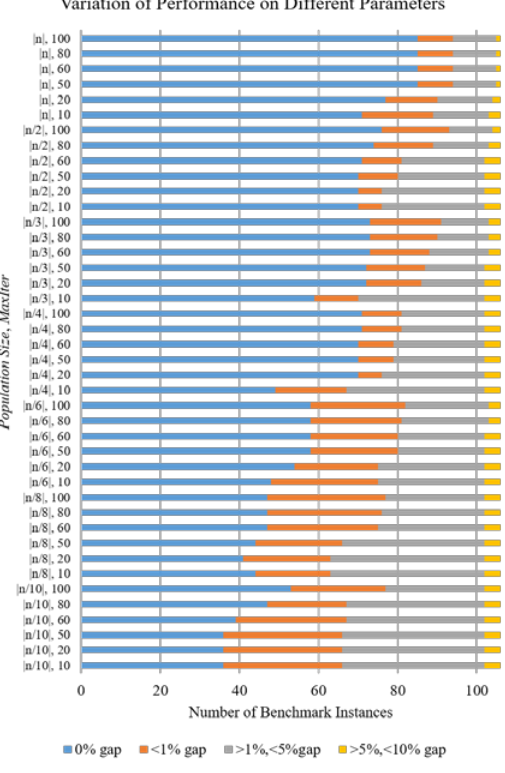
Figure 5. Variation in convergence of BLS-PSO depending on different PS Particle & T .